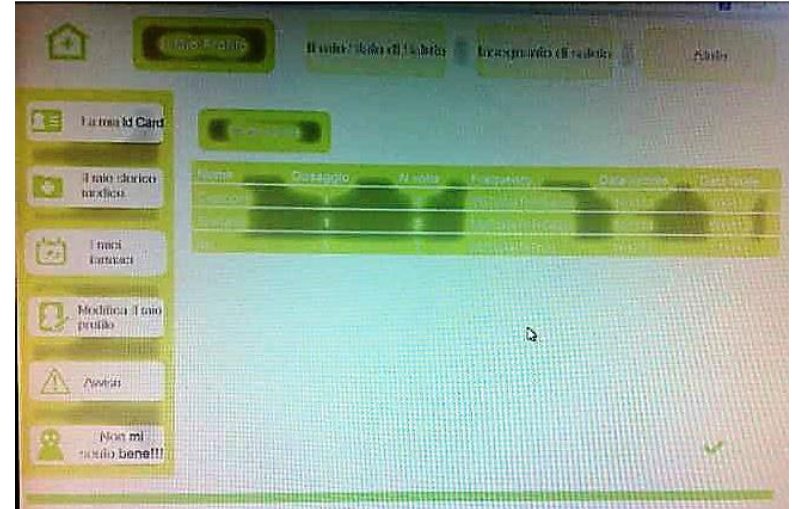
Figure 13. UI visual perception of User 2 using the application.